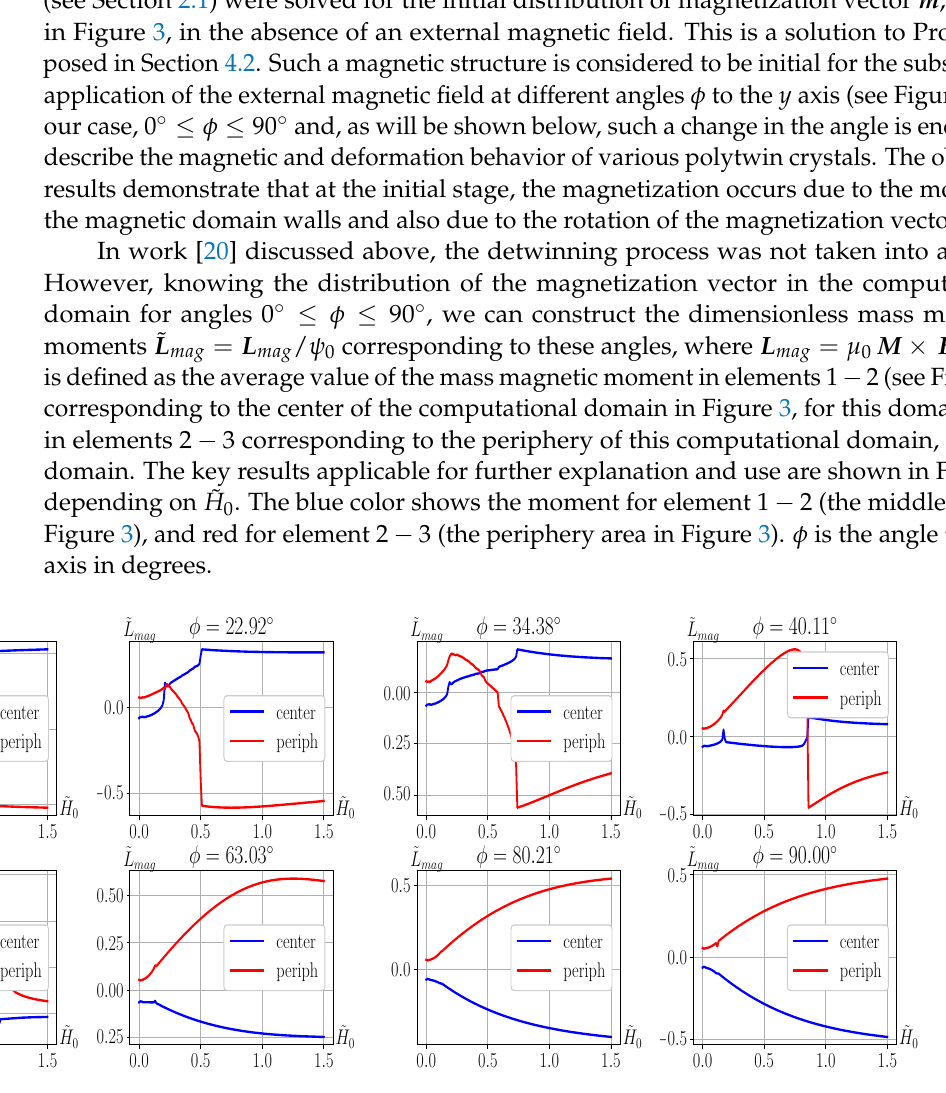
3 (the periphery area in Figure 3). −